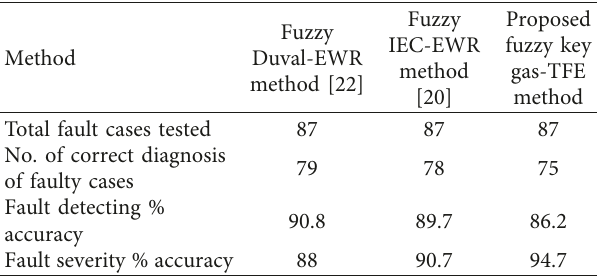
Table 7: Comparison of severity accuracies of fault diagnosis